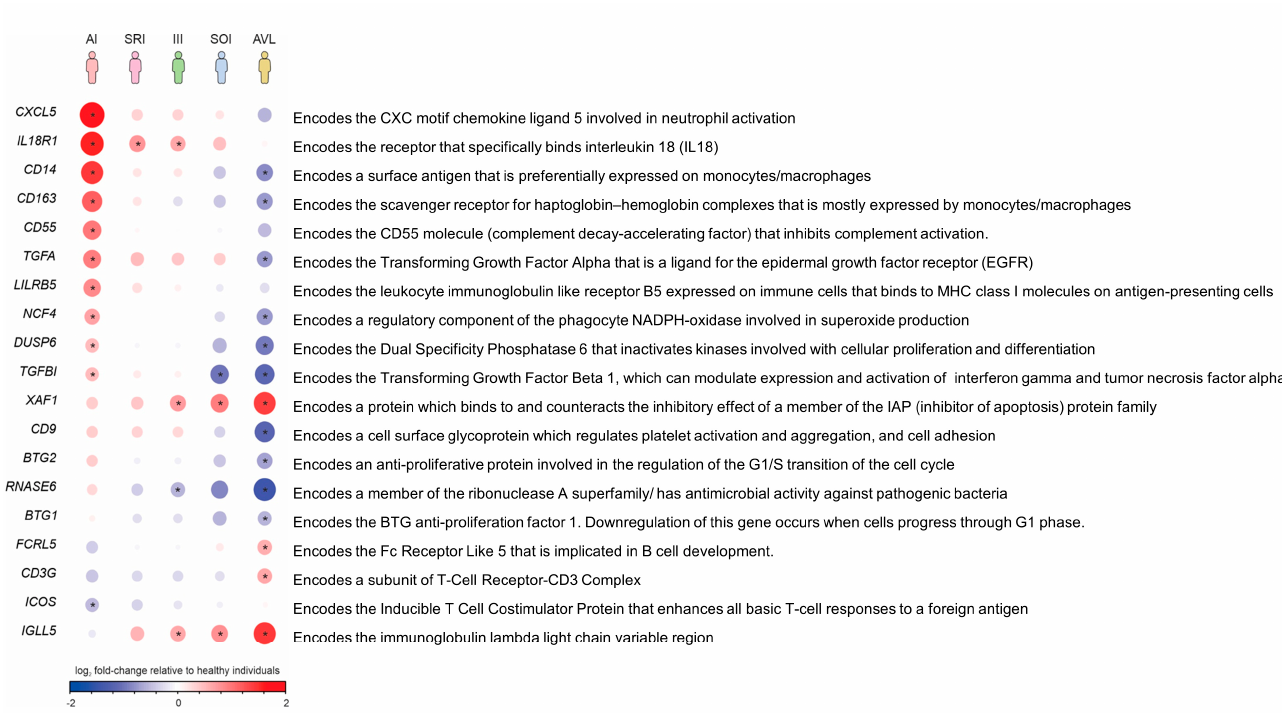
Figure 3. Reactome pathways enriched with genes up-regulated on each infection profile. The color and size of the circles are proportional to the significance of the enrichment.